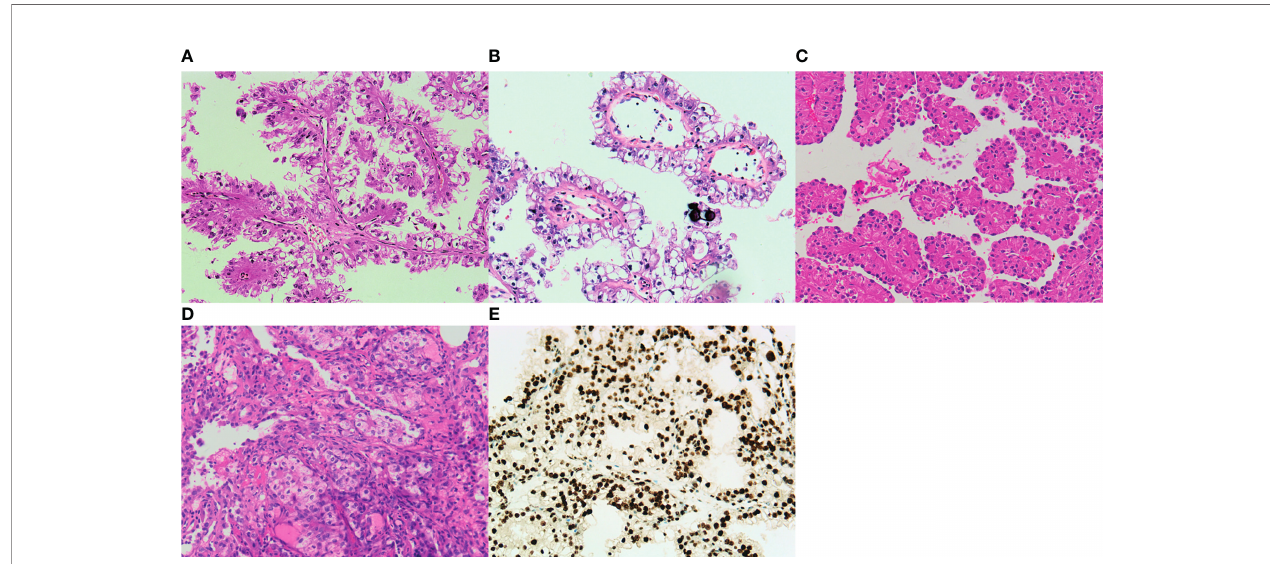
FIGURE 1 | Representative images of the typical morphological features of Xp11.2 translocation renal cell carcinoma (RCC). (A) ASPL – TFE3 fusion type shows a predominantly papillary morphology lined by pseudostrati fi ed clear to oncocytic cells. (B) Psammoma bodies are also present in ASPL – TFE3 Xp11.2 translocation RCC. (C) An alveolar pattern or organoid pattern populated by eosinophilic cells is noticed in the PRCC – TFE3 fusion type. (D) Xp11.2 translocation RCC with a novel fusion partner. VCP demonstrates a solid nested/alveolar pattern with predominant eosinophilic cells to focal clear cytoplasm. (E) Diagnostic TFE3 reaction strongly labeled the nuclei in the VCP – TFE3 fusion type. All images have a magni fi cation factor of ×200.